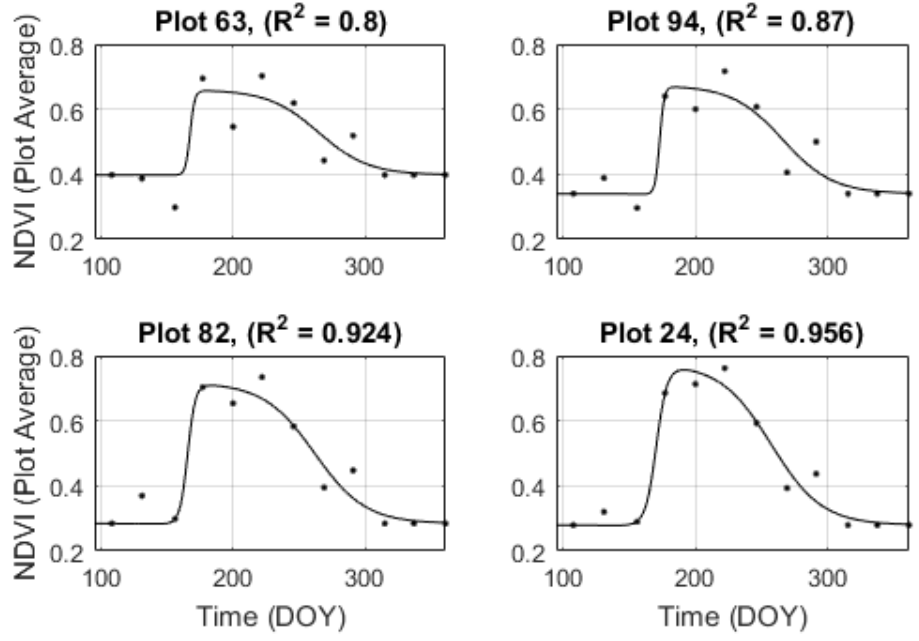
Figure 8. Four different plot-average NDVI time-series resampled to a 23-day average revisit interval and fit to the asymmetric double sigmoid